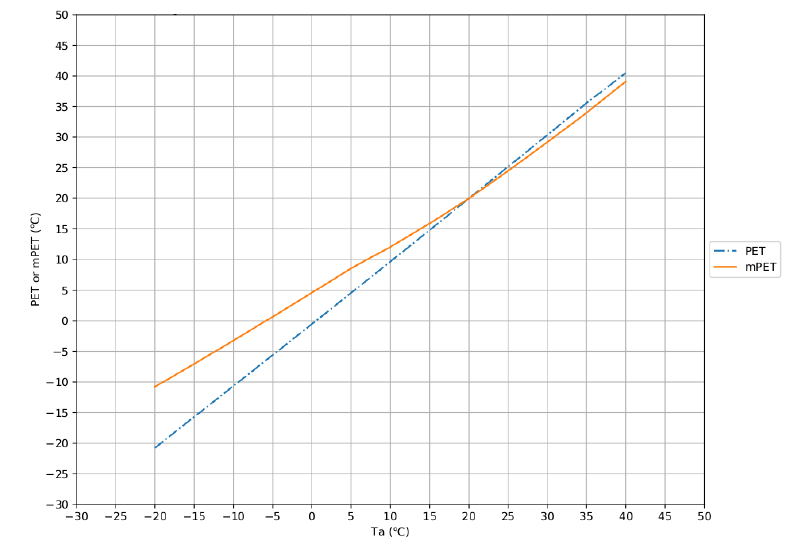
Figure 5. The comparison of PET and mPET in different T a .